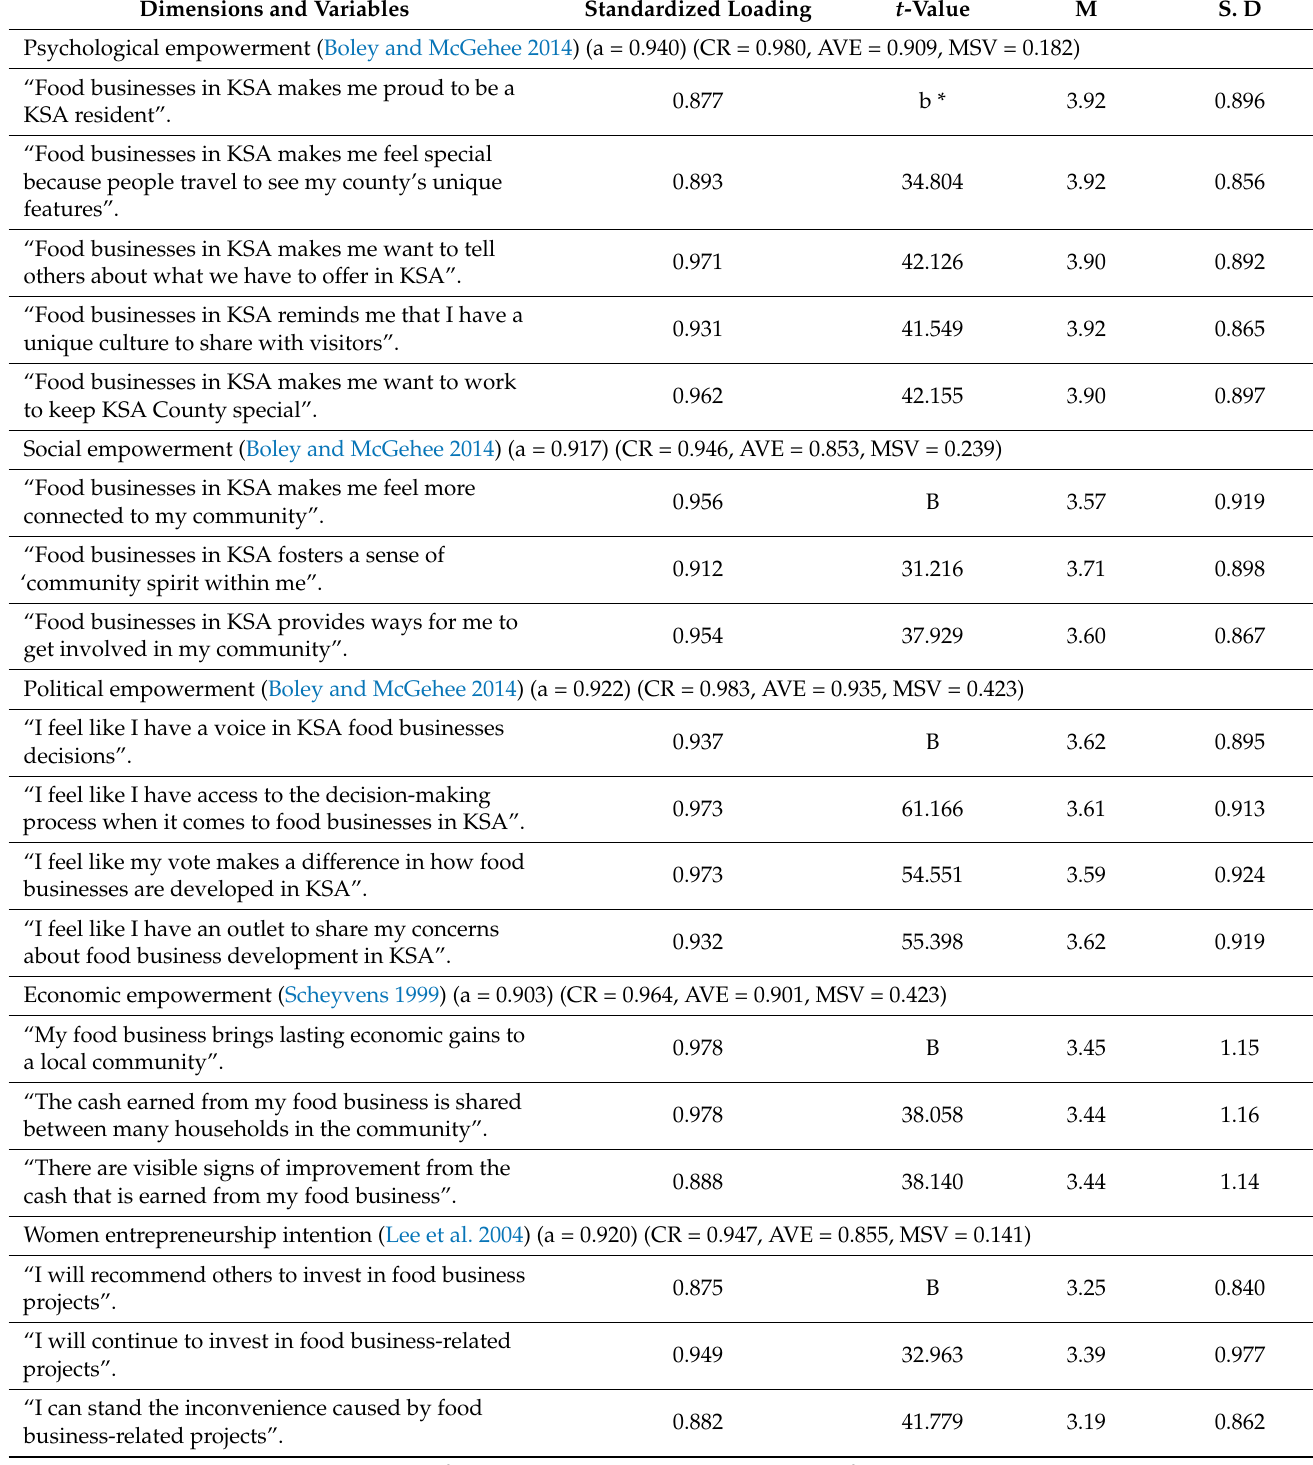
Table 1. Results of CFA for discriminant and convergent